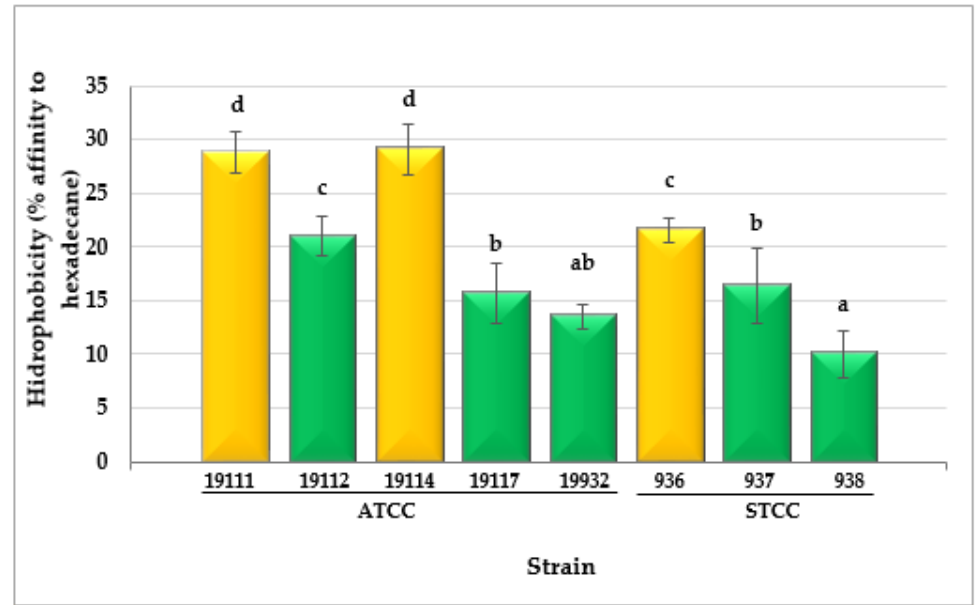
Figure 3. Cell surface hydrophobicity (CSH) values observed for cultures of eight Listeria monocytogenes strains. Data are means ± standard deviations (SD) for eight determinations. Mean values with no letters in common are significantly different ( p < 0.05). ATCC—American Type Culture Collection; STCC—Spanish Type Culture Collection. The green columns represent weak CSH; the yellow columns represent moderate CSH.